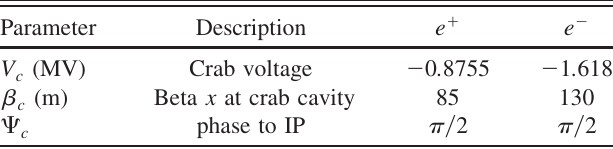
TABLE II. Parameters associated with crab cavities in simu- lation. The rf frequency f rf ¼ 509 MHz .